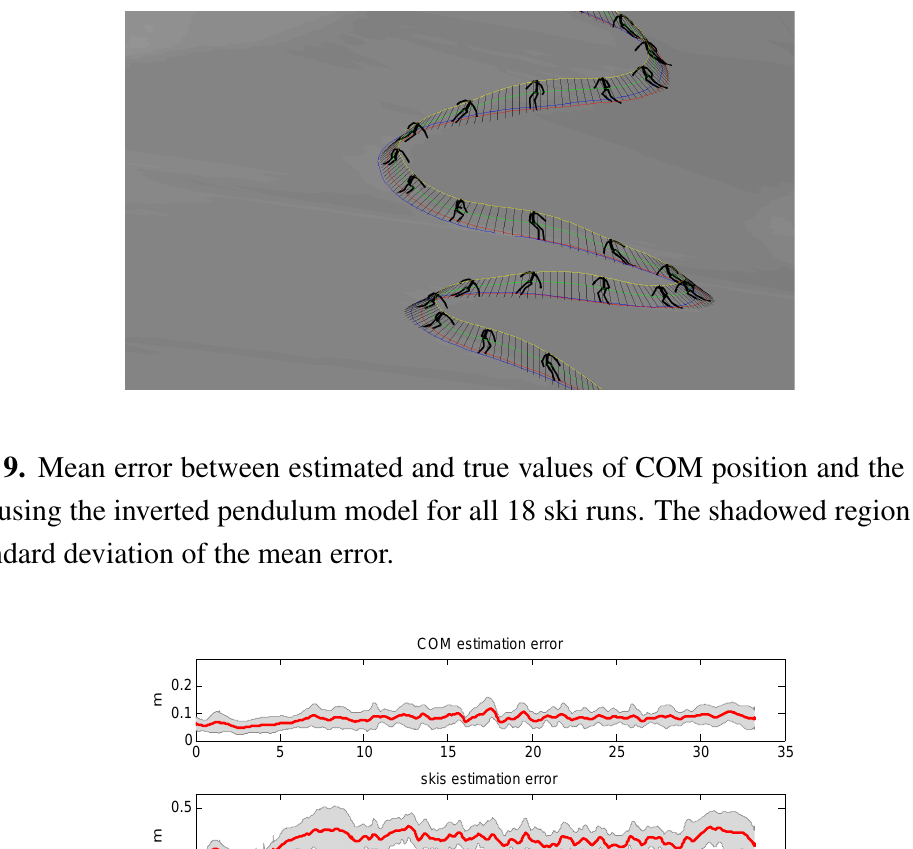
Figure 8. A comparison of inverted pendulum model (black line) and measured pose based on a 22 segment model. Yellow, green, red and blue color denote the antenna, COM, right ski and left ski trajectories, respectively.